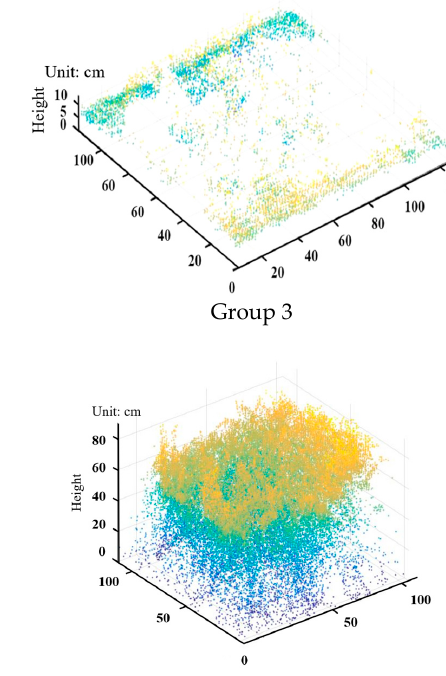
10 of 14 Table 3. Accuracy evaluation of plant height calculation of rice. Group Number